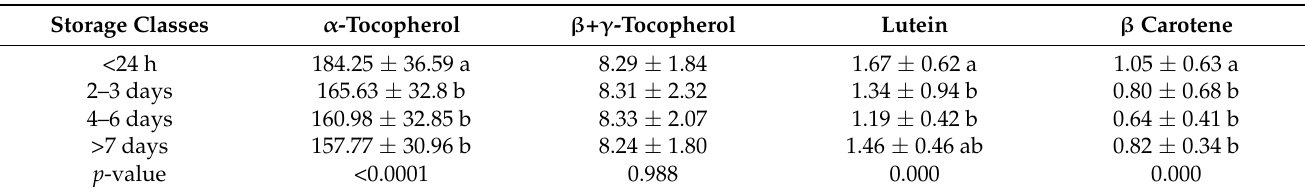
Table 3. Tocopherol and carotenoid content in oil samples after different olive storage durations. Values are mean ± standard deviation. Compounds are expressed as mg of relative standard compound per kg of oil. Values followed by different letters in the same column (a, b) were significantly different according to Tukey’s test ( p <